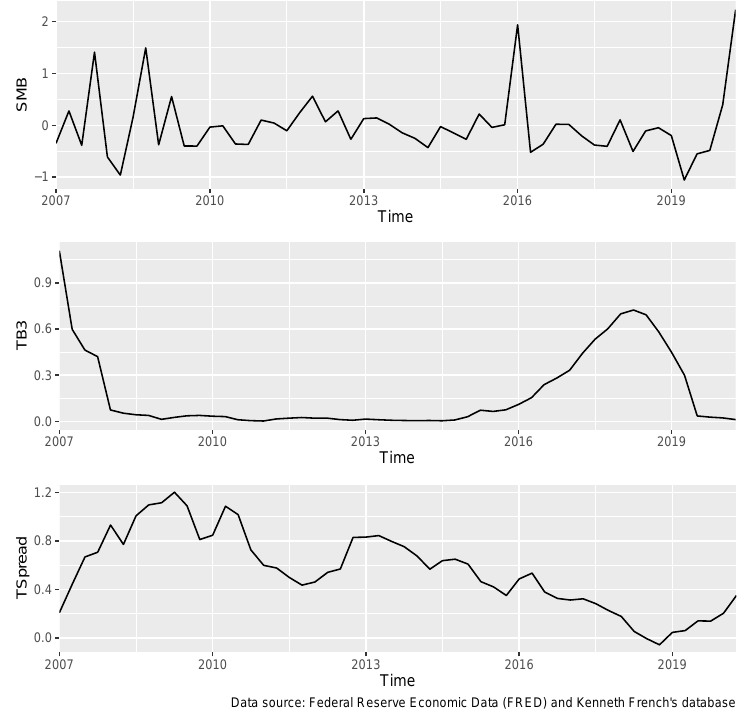
Figure A4. Asset Pricing/Macro Control Variables